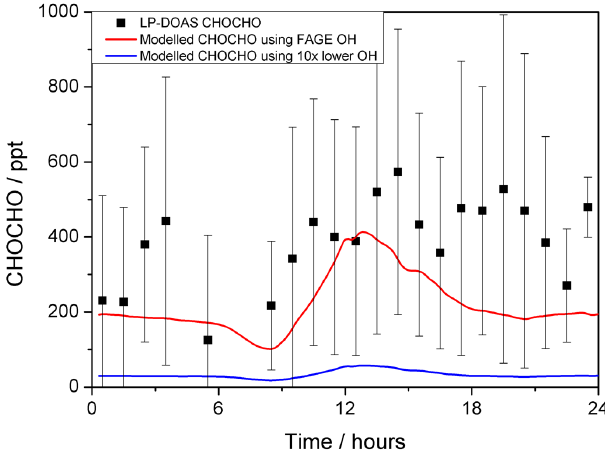
Fig. 14. Measured (black squares) and modelled CHOCHO using FAGE OH measurements (red line) and using an order of magnitude lower OH (blue line) for campaign